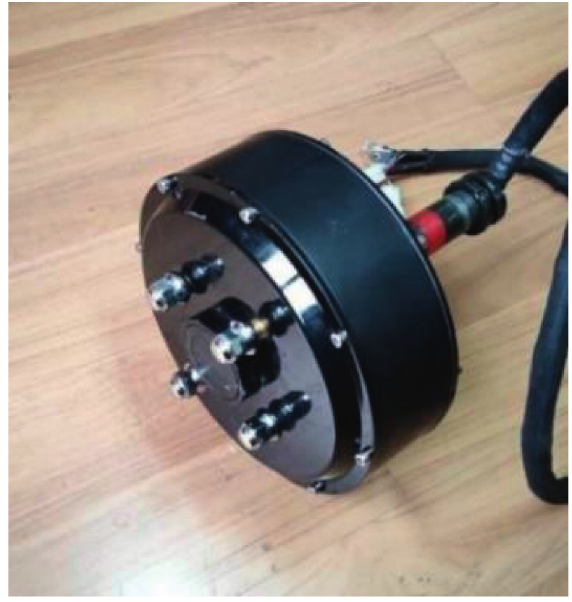
Figure 1: The outer-rotor PMBLDC motor.